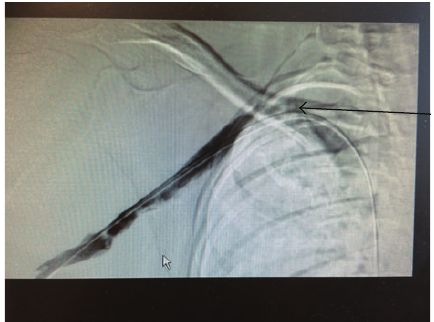
Figure 2: Extensive right upper extremity deep venous thrombosis on venogram.